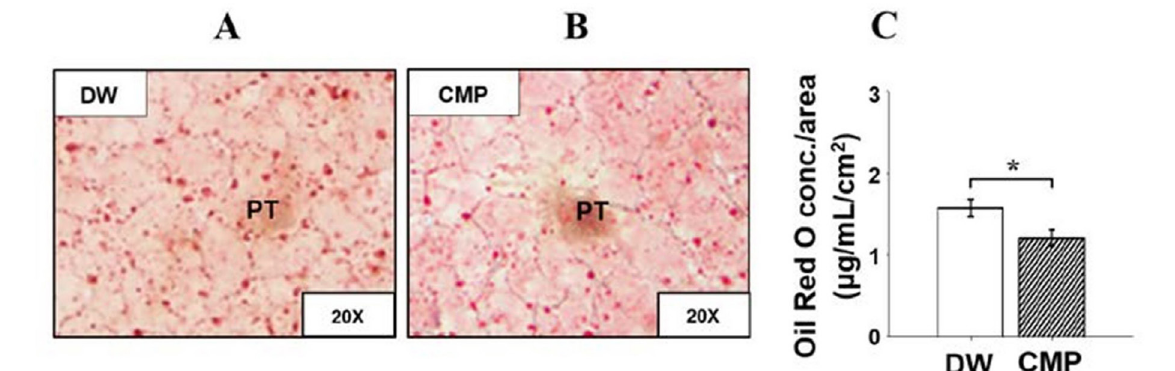
FIGURE 3 - Effects of CMP (1 g/kg) or distilled water (DW) consumption by the middle-aged male rats on liver cell lipid accumulation. (A) Distilled water (DW), (B) CMP and (C) oil red O concentration. Values represent mean ± SEM of 6 experiments. * Significantly lower than that of the distilled water control group, P < 0.05. (PT = Portal triad; oil red O staining of liver tissue frozen section, 20 mm thick, 20X